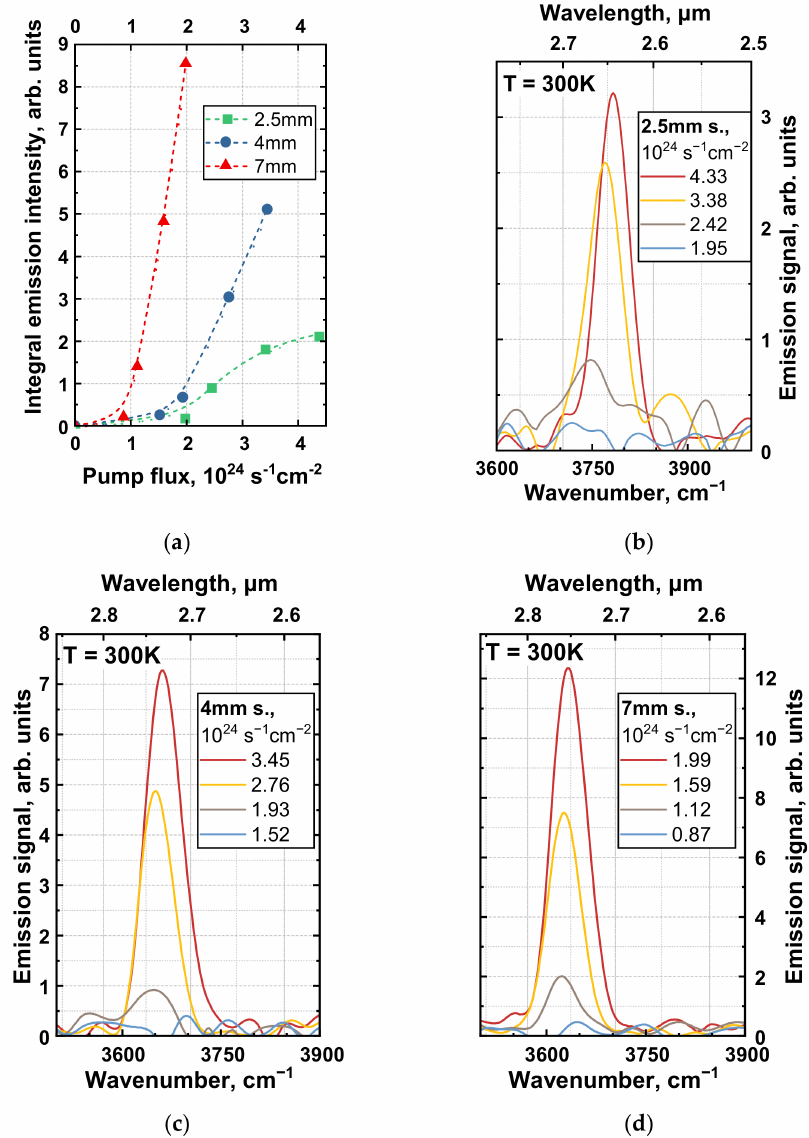
Figure 3. ( a ) Room-temperature light-in versus light-out (L–L curves) characteristics for each sample. Emission spectra of the ( b ) 2.5 mm sample, ( c ) 4 mm sample, ( d ) 7 mm sample under various excitation photon fluxes of the 2 µ m pulsed excitation (source (ii)). Arbitrary units in ( b – d ) are the same for all three